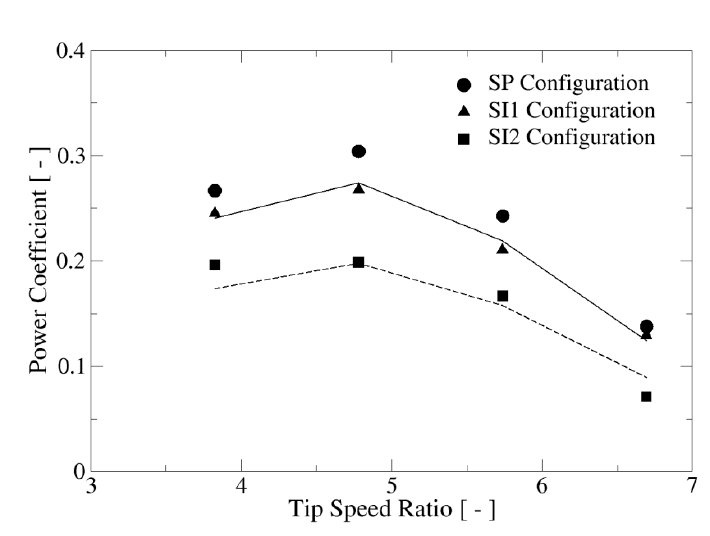
Figure 13. The evaluation of the correlation cos 3 γ , Equation (8), for the inclined turbine configurations. Lines indicate the correlation: 15° inclination: solid line; 30° inclination: dashed line.